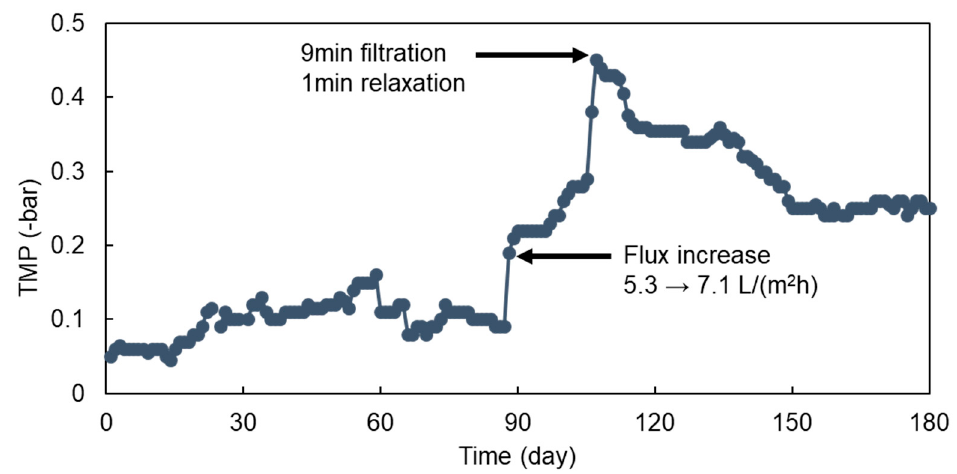
Figure 2. The TMP change of AFMBR with operation time.